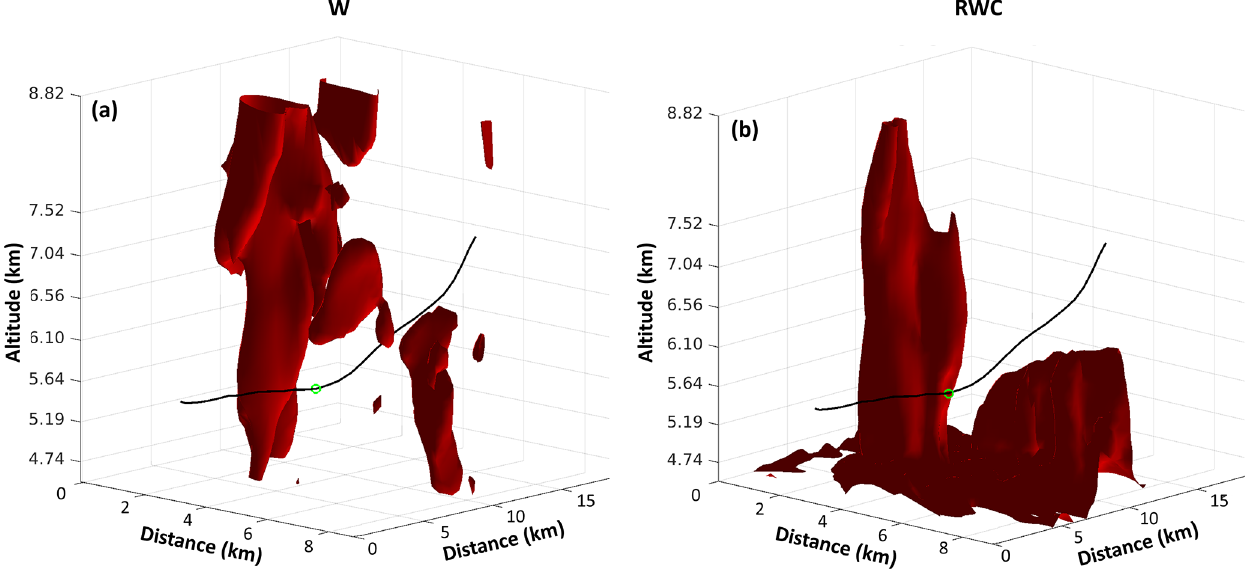
Figure 19. The trajectory of a specific air parcel (black line), and the location of the parcel at t = 0min (green circle). The red surfaces in panel (a) show the area with w larger than 3ms − 1 at the moment of t = 0min, and red surfaces in panel (b) show the area with RWC larger than 0.05gm − 3 at the moment of t =